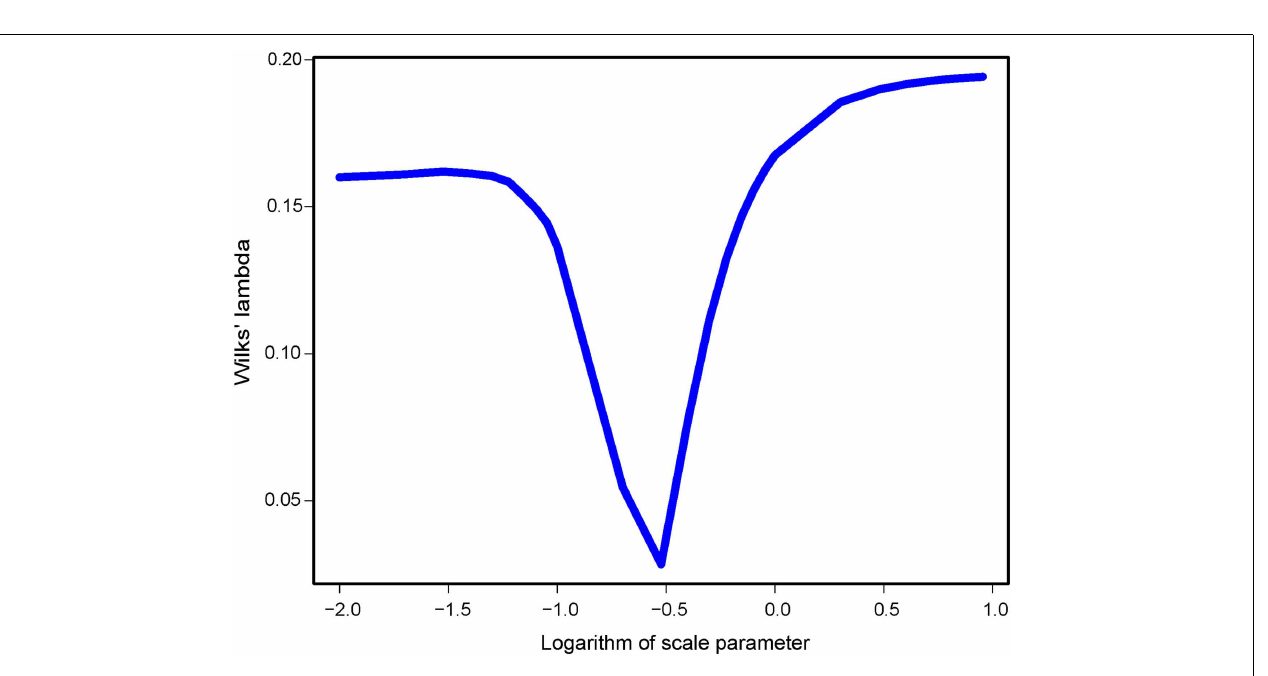
FIGURE 5 |Wilks’ (cid:51) statistic as a function of the scale parameter θ/ ¯ d in spFA.